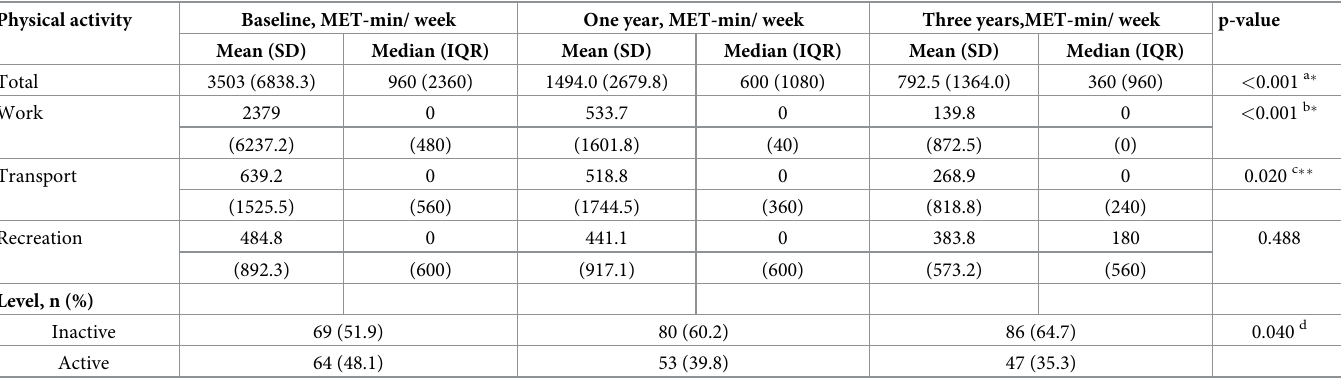
Table 3. Physical activity levels at baseline, one year and three